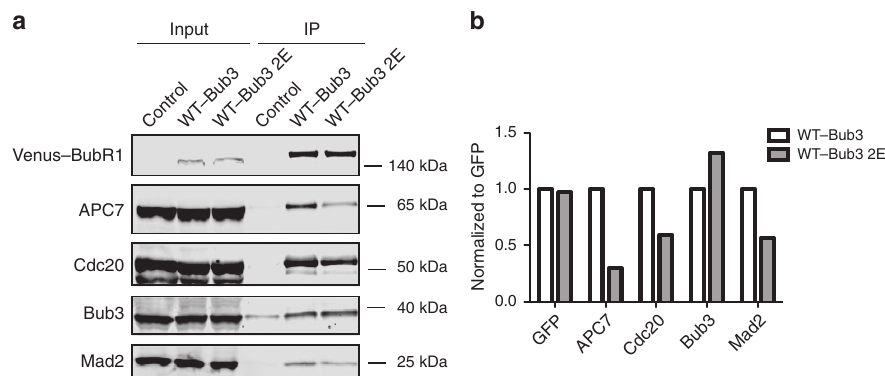
Figure 6 | Preventing direct BubR1–MELTp binding reduces MCC formation. ( a ) HeLa cells were transfected with BubR1 RNAi oligos together with RNAi-resistant Venus-tagged BubR1–Bub3 or BubR1–Bub3 2E constructs for 48h. After nocodazole treatment, mitotic cells were collected and lysed. Immunoprecipitation was performed against the Venus tag by GFP-Trap beads. The presence of APC7, Bub3 and Cdc20 and Mad2 was analysed by Li-cor quantitative western blot. ( b ) Western blot results were quantified and plotted. The signal from BubR1–Bub3 was set to 1.